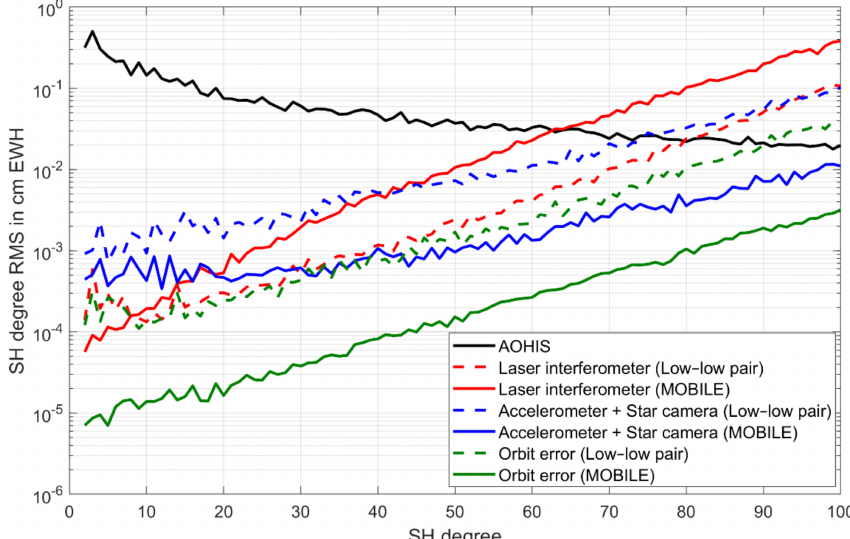
Figure 5. Degree (error) standard deviations after 1 month of full AOHIS signal (black), low–low pair formation (dashed curves), and MOBILE constellation (continuous curves), when including only distance measurement errors (red), acceleration plus star camera errors (blue), and orbit errors